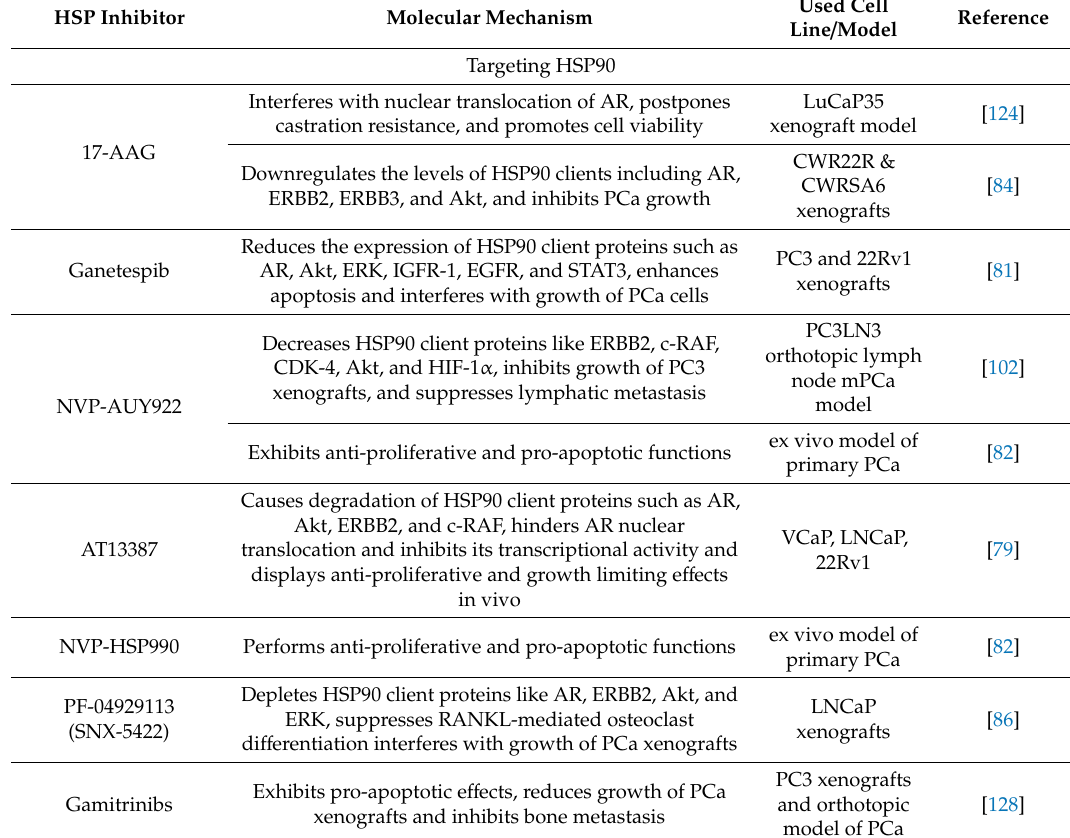
Table 3. Common HSP targeting therapies in prostate